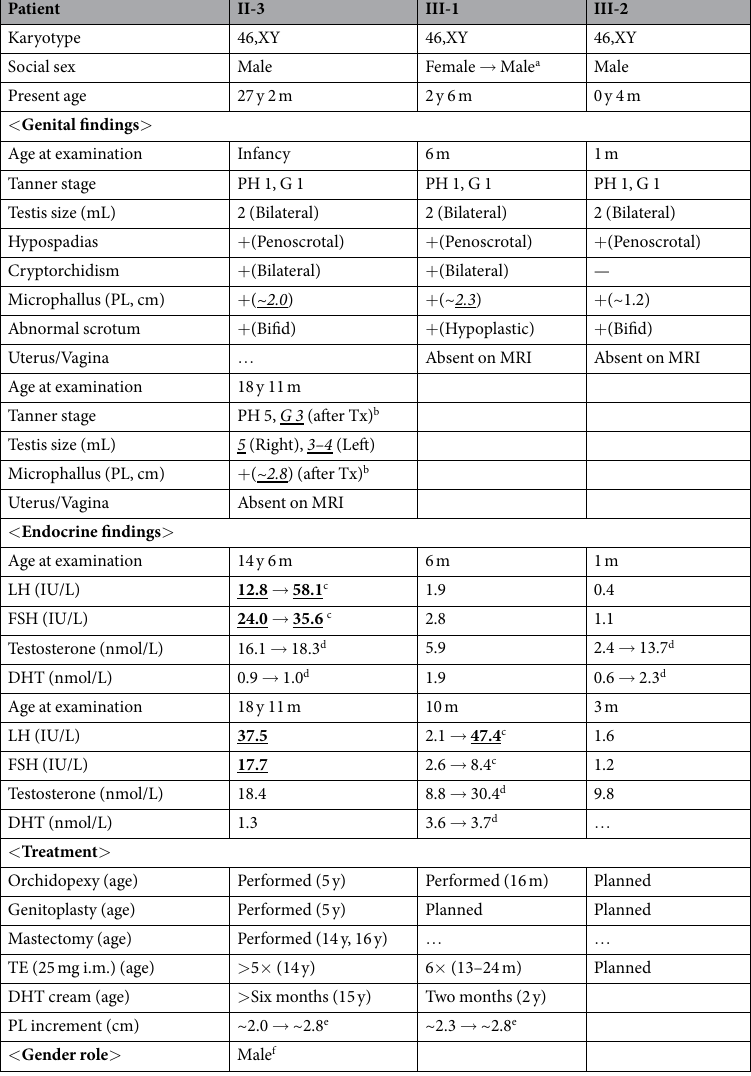
Table 1. Clinical findings of three patients examined in this study Abbreviations: PL, penile length; LH, luteinizing hormone; FSH, follicle stimulating hormone; DHT, dihydrotestosterone; TE, testosterone enanthate; y, year; m, month; PH, pubic hair; G, genitalia; Tx, treatment; and MRI, magnetic resonance imaging. The data below the age-matched reference values 19–22 are italicized and underlined, whereas those above the age- matched reference values 19–22 are boldfaced and underlined. a Social sex was changed from female to male at 12 months of age after detailed examinations and thorough consultation. b Treatment with TE injection and topical DHT cream, as described below. c Basal and peak values during a gonadotropin releasing hormone